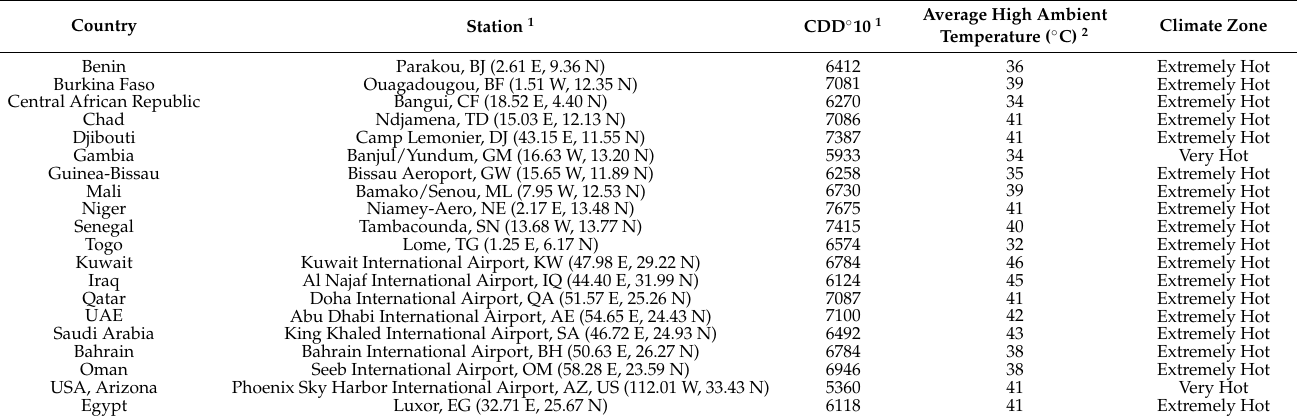
Table 2. Average high temperature for the hottest month of the year [18] and CDD ◦ 10 [19].